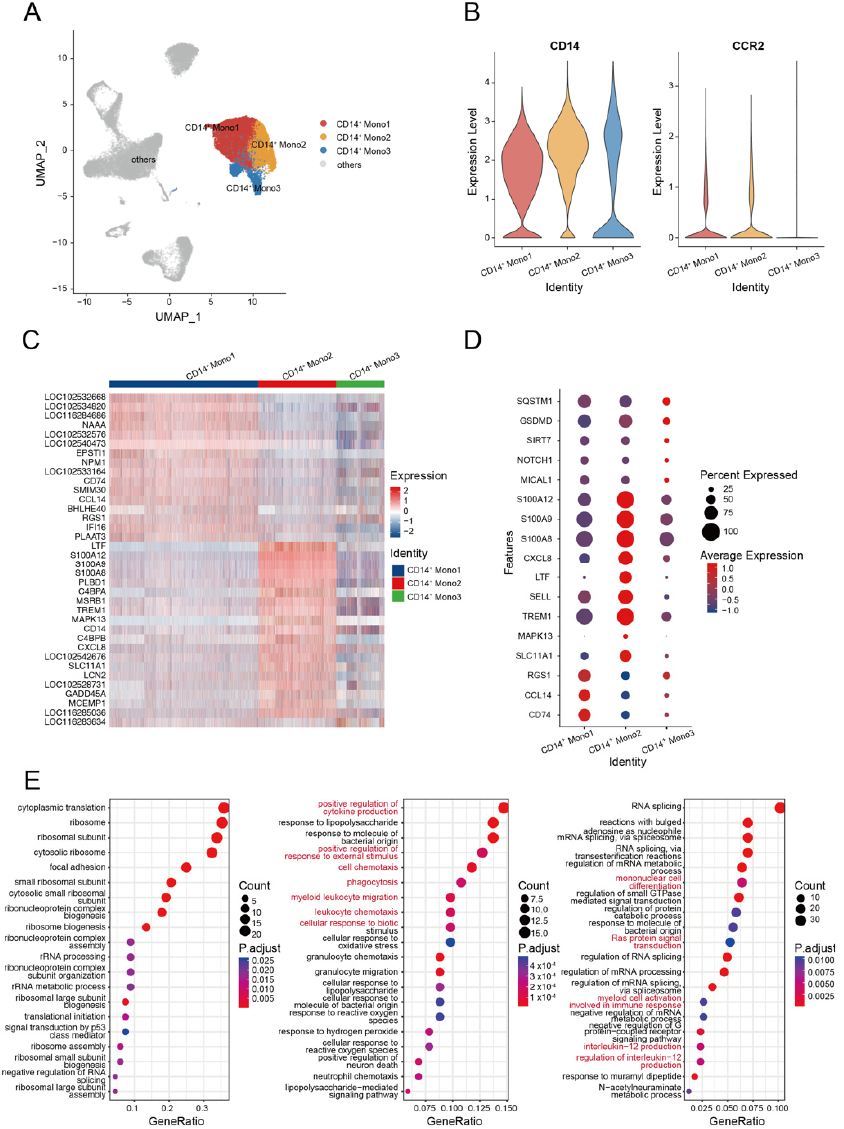
Figure 2. Examination of subclusters of monocyte cells in HA-stimulated PBMCs. ( A ) UMAP plot shows the results of sub-clustering involving monocyte cells. ( B ) The classic marker gene was identified in three clusters. ( C ) Heatmap shows differential gene expression patterns in various monocyte cell types. ( D ) Dotplot shows the marker gene expressions pattern in various clusters. ( E ) Representative GO terms and pathways enriched in DEGs of various monocyte cell subsets of PBMCs. Left, CD14 + Mono1; middle, CD14 + Mono2; right, CD14 + Mono3.